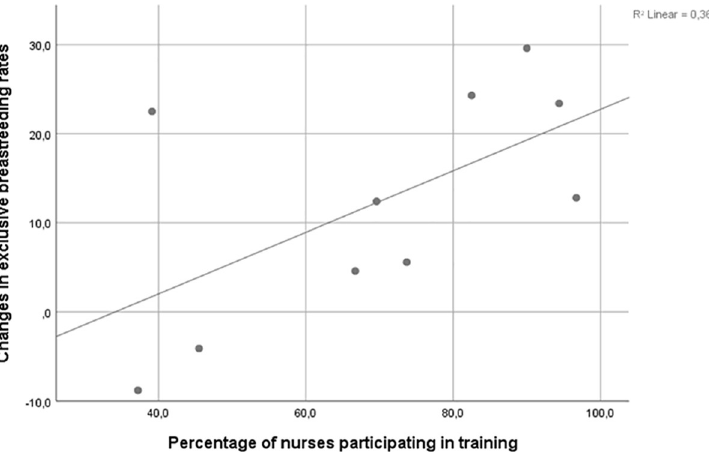
Fig 2. Changes in exclusive breastfeeding rates in NICUs according to percentage of nurses participating in training.